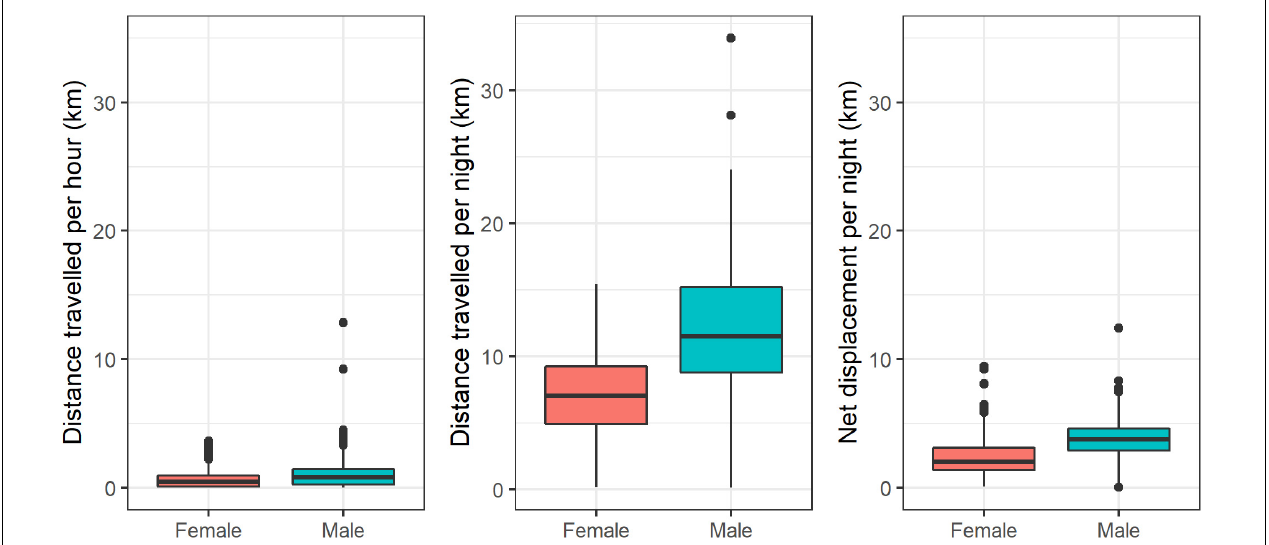
FIGURE 6 | Distributions of movement metrics for male and female striped hyenas in the Central District of Israel. Left panel: distance traveled per hour; center panel: distance traveled per night; right panel: nightly net